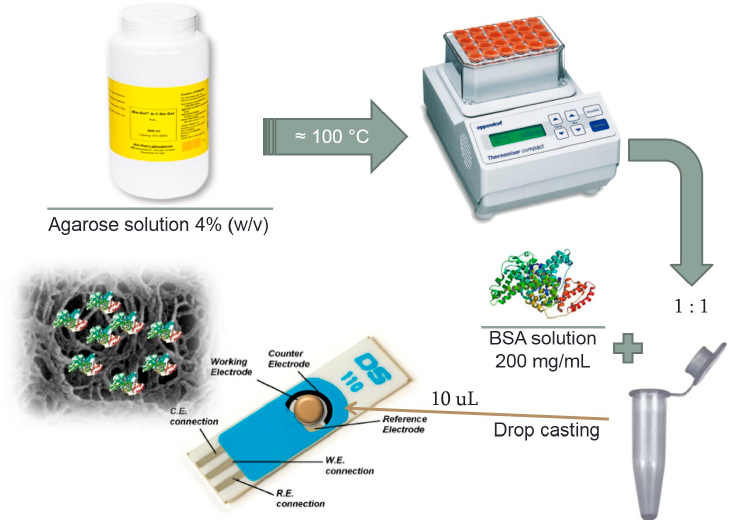
Figure 3. Graphical representation of the SPE